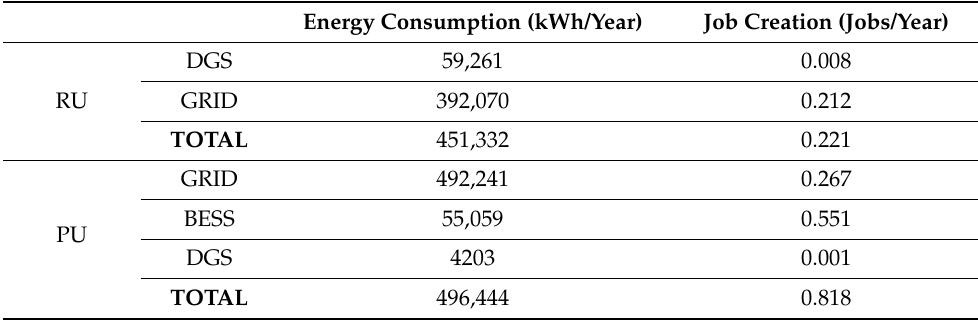
Table 10. Summary of annual energy consumption and job creation for each RU and PU energy